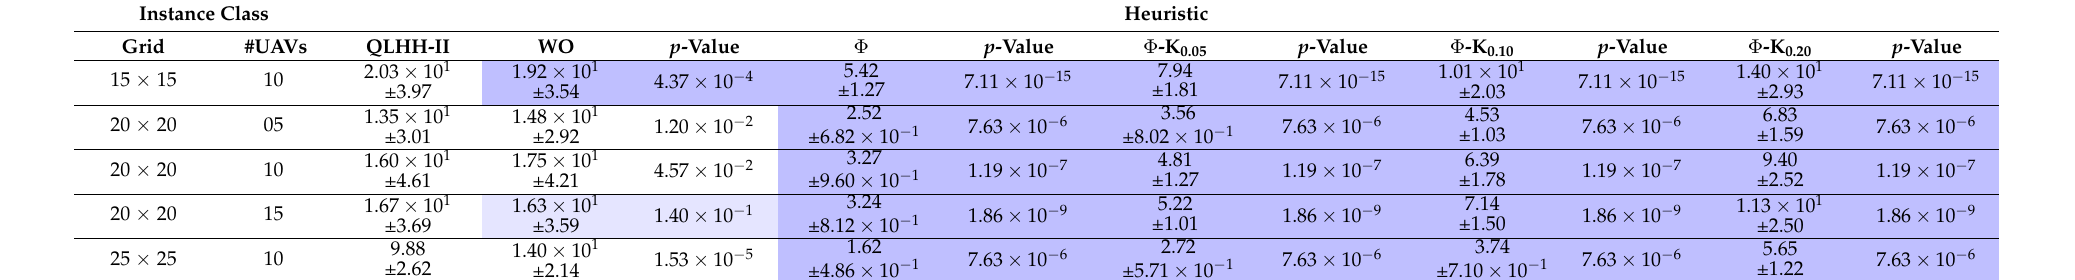
Table 3. Comparison between heuristics according to HV.